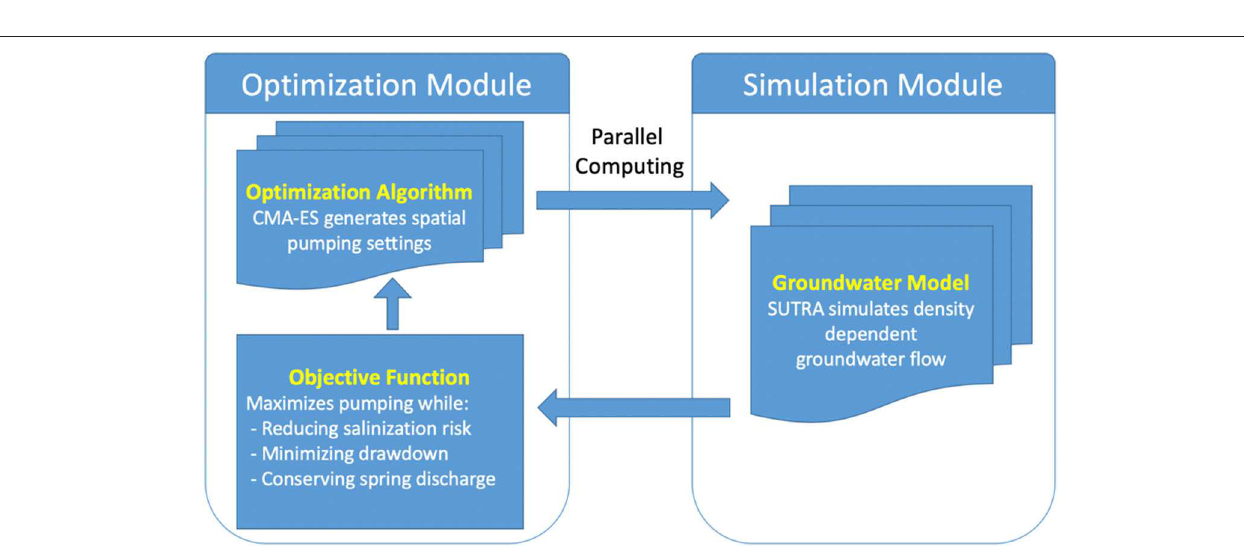
FIGURE 5 | Maps of the Pearl Harbor aquifer showing: (A) wells categorized by aquifer formation, aquifer management unit, and owner; (B) current pumping of pumping wells to identify potential decision variables) and current spring discharge; (C) optimal solution with 27 decision variables.